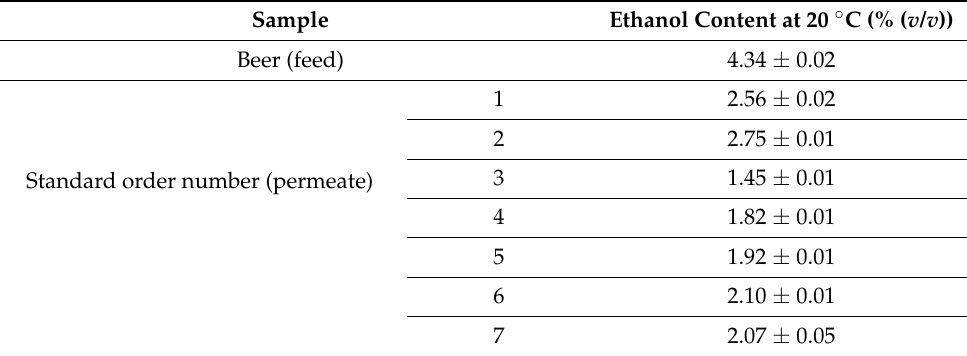
Table 7. Ethanol content values of beer and permeate samples at 20 ◦